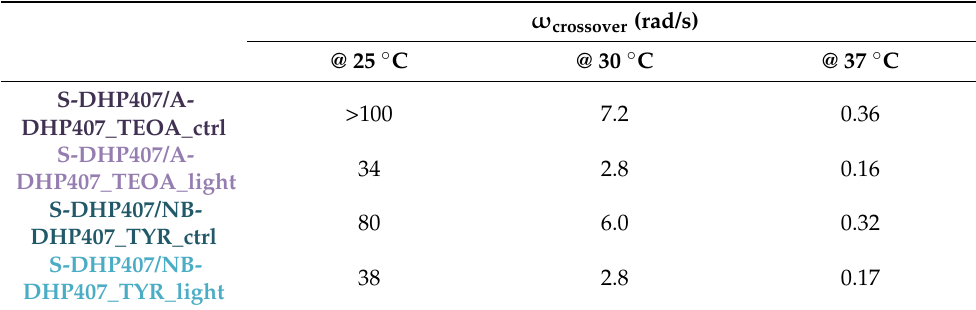
Table 2. Crossover frequency between G’ and G” trends ( ω crossover ) measured for thiol-acrylate and thiol-norbornene formulations before and after exposure to visible light (525 nm, 80,000 Lux, 10 min) in the presence of a co-initiator (i.e., TEOA and